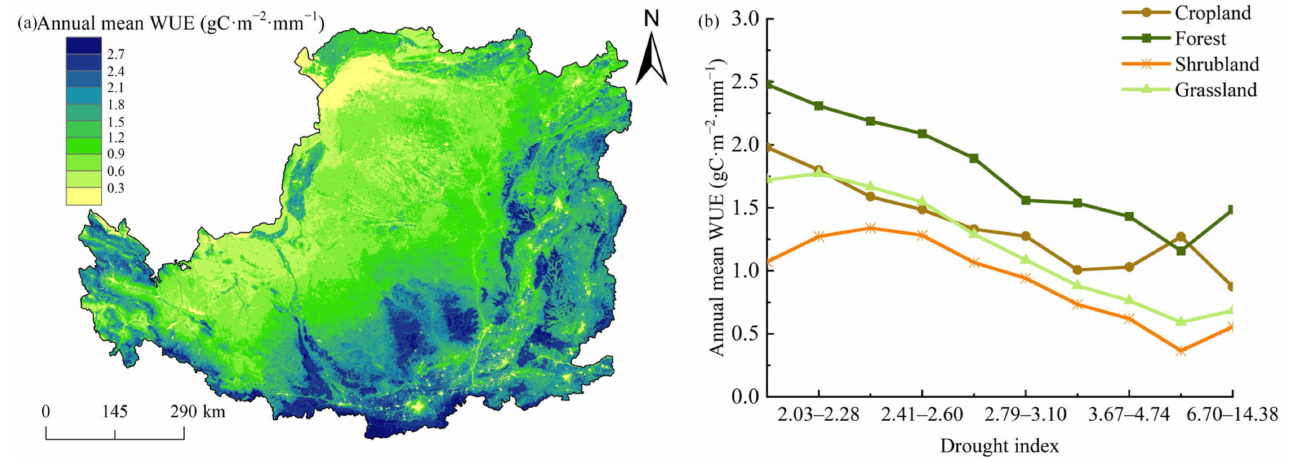
Figure 3. ( a ) Spatial distribution of the WUE and ( b ) the annual mean WUE of the different vegetation types.